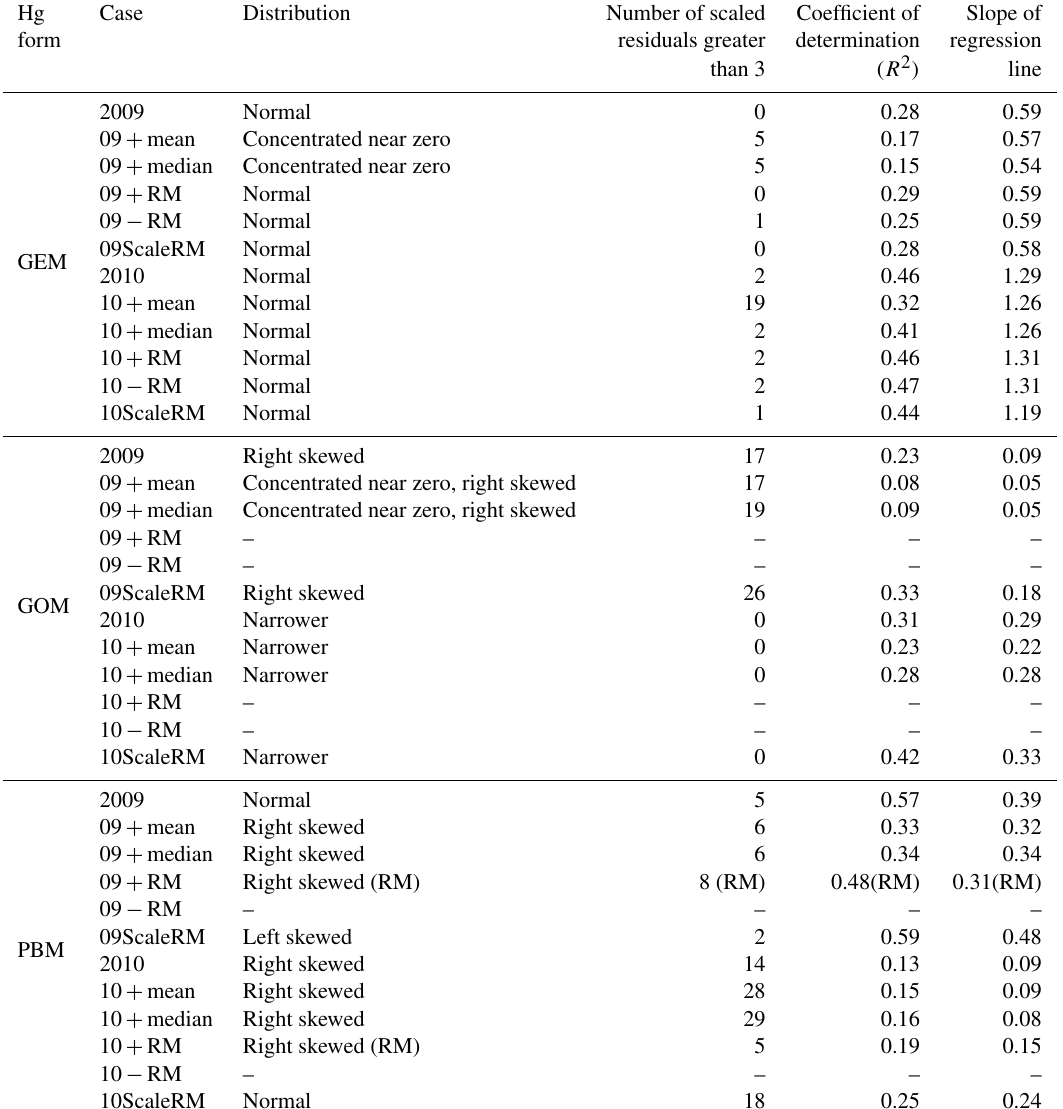
Table 6. PMF model performances on speciated mercury in 2009 and 2010. Hg Case Distribution Number of scaled Coefficient of Slope of form residuals greater determination regression